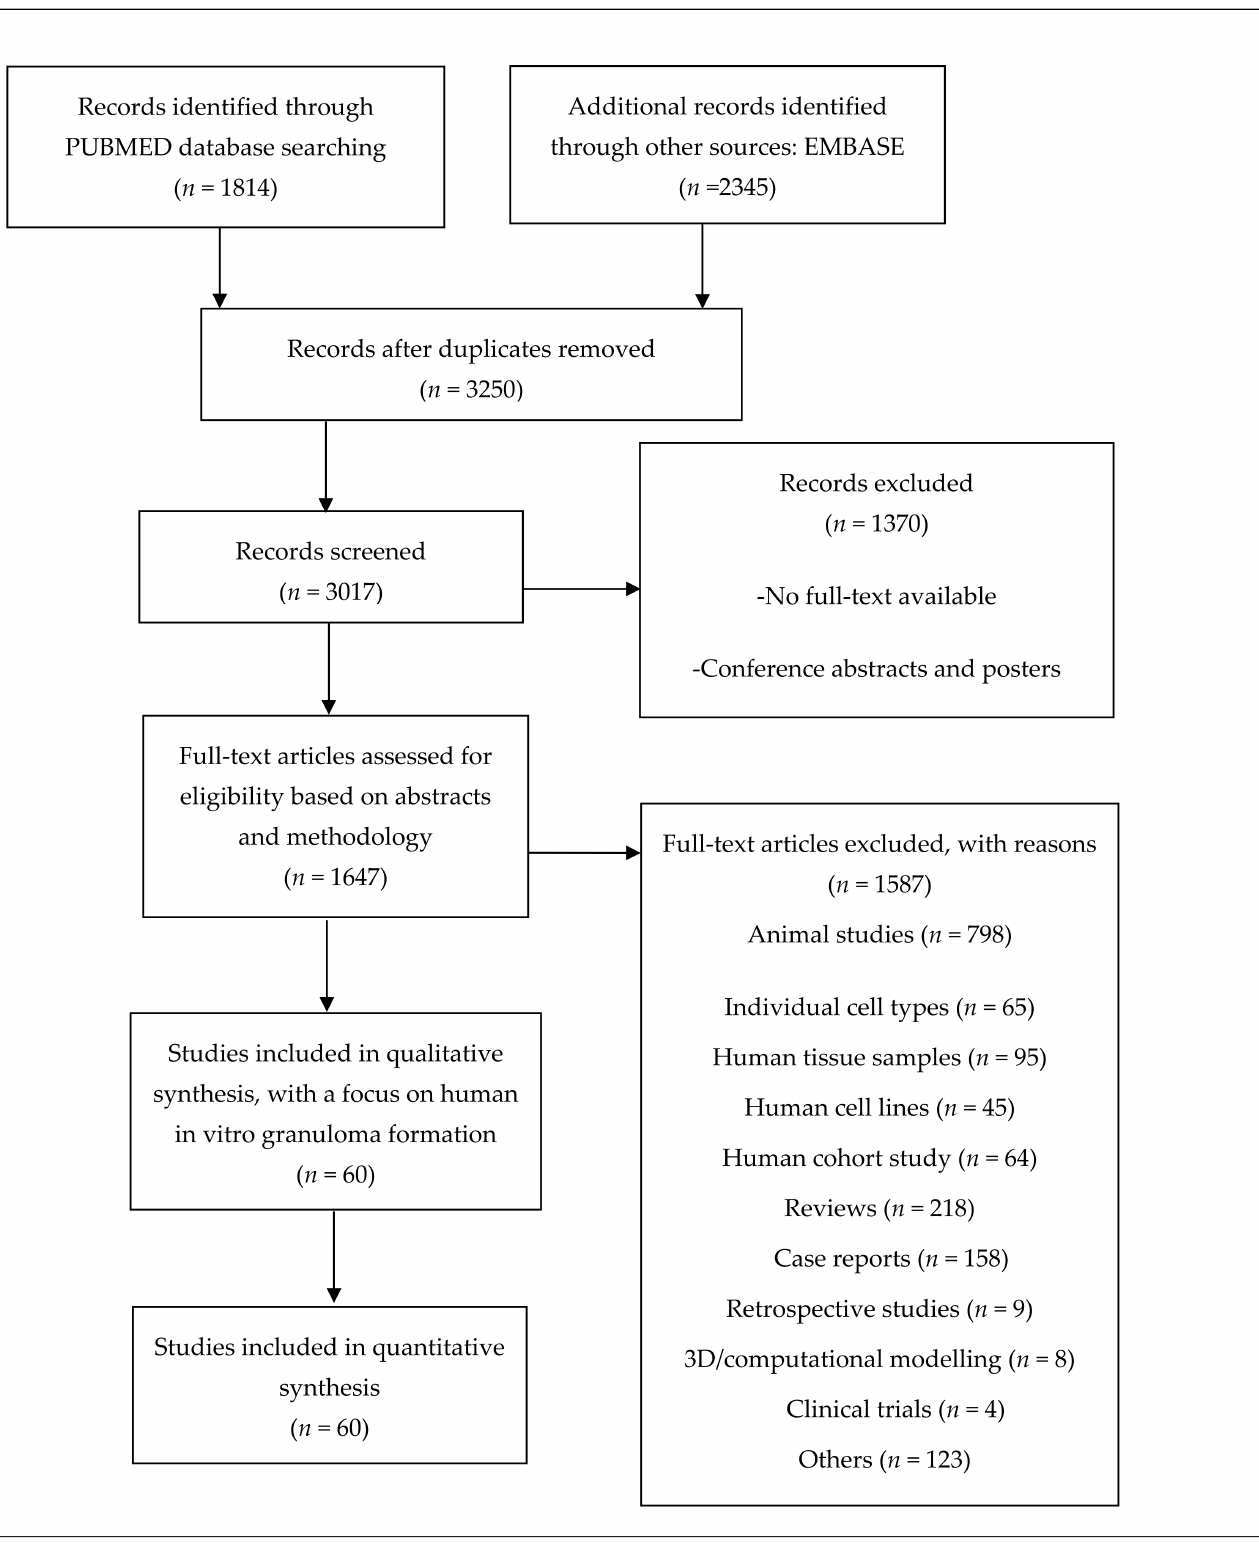
Figure 2. Workflow of literature review. Studies included were selected based on the following criteria: (1) a focus on in vitro granuloma modelling with human-derived peripheral blood mononuclear cells (PBMCs) and (2) successful granuloma development with an agent of choice. Other studies that focused on individual cultures of cells from PBMCs were excluded to avoid contradictions in the analyses. An overview of the included studies can be found as part of the Supplementary